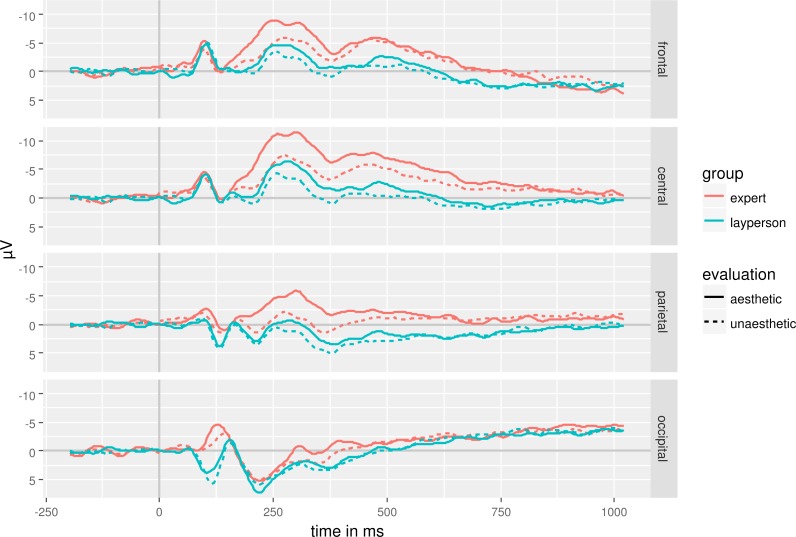
EEG-signal as a function of expertise, aesthetics and anterior–posterior regions of interests.